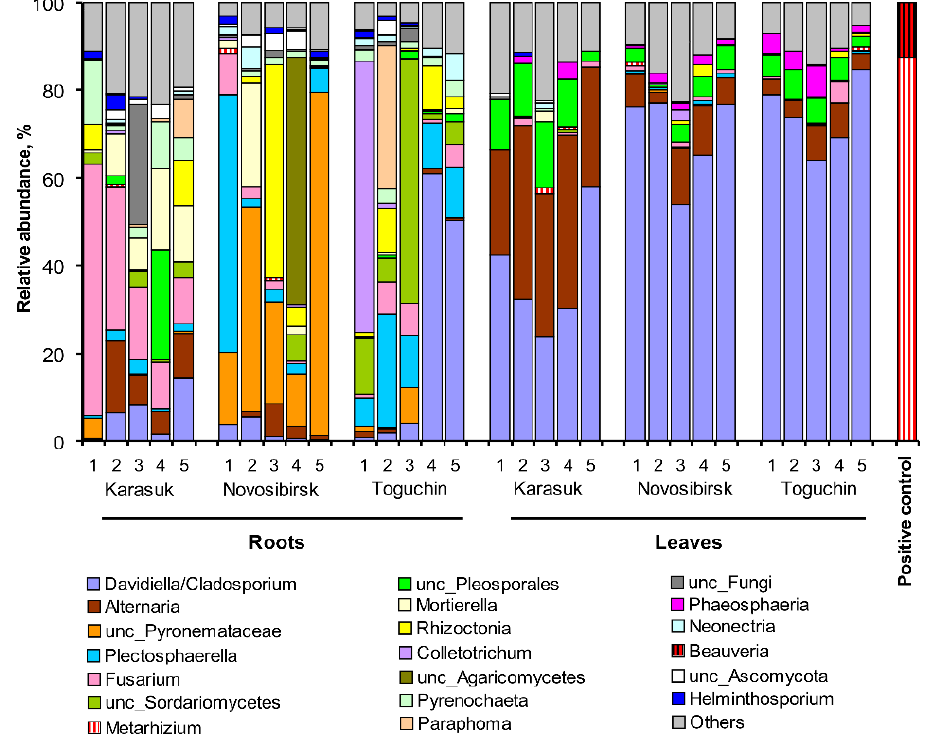
Figure 3. Fungal communities of surface-sterilized potato roots and leaves from kitchen gardens (Karasuk, Toguchin) and a conventional agrosystem (Novosibirsk) in 2020 as estimated by ITS metagenomics sequencing at the genus level. Five samples for each point are presented. The positive control was a mixture of M. robertsii and B. bassiana conidia. Crosstalk algorithm was not